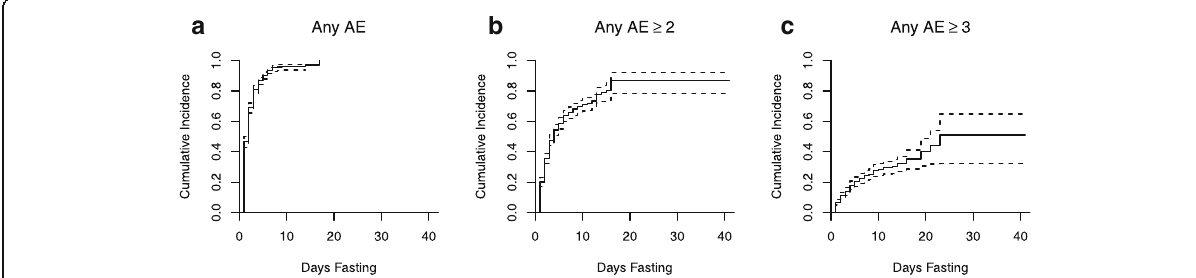
Fig. 2 Cumulative incidence of adverse events by fast length. Kaplan-Meier curves (solid line) and 95% confidence intervals (dashed line) for ( a ) any AE; ( b ) any AE greater than or equal to 2 and; ( c ) any AE greater than or equal to